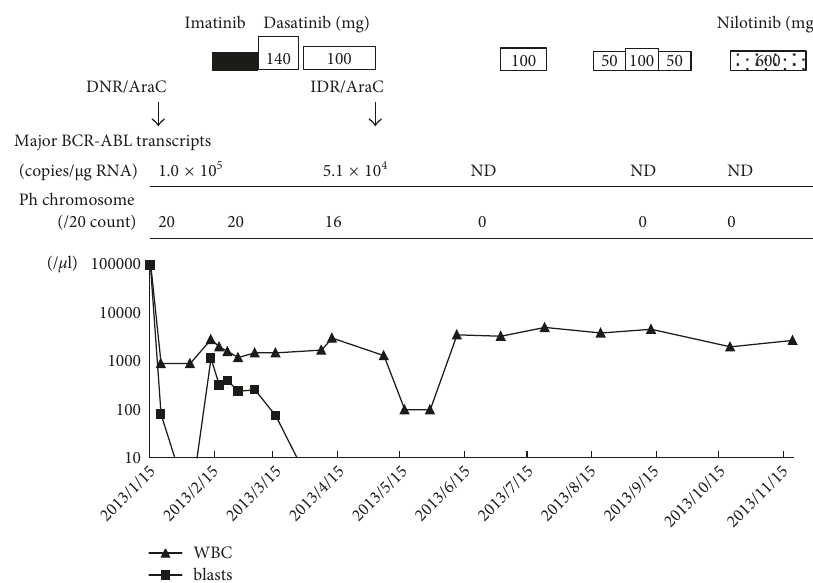
Figure 1: Clinical course. The kinetics of the hematological, cytogenetic, and molecular responses to tyrosine kinase inhibitors and conventional chemotherapy seen during the patient’s clinical course are shown. Ara-C: cytosine arabinoside, DNR: daunorubicin, IDR: idarubicin, and ND: not